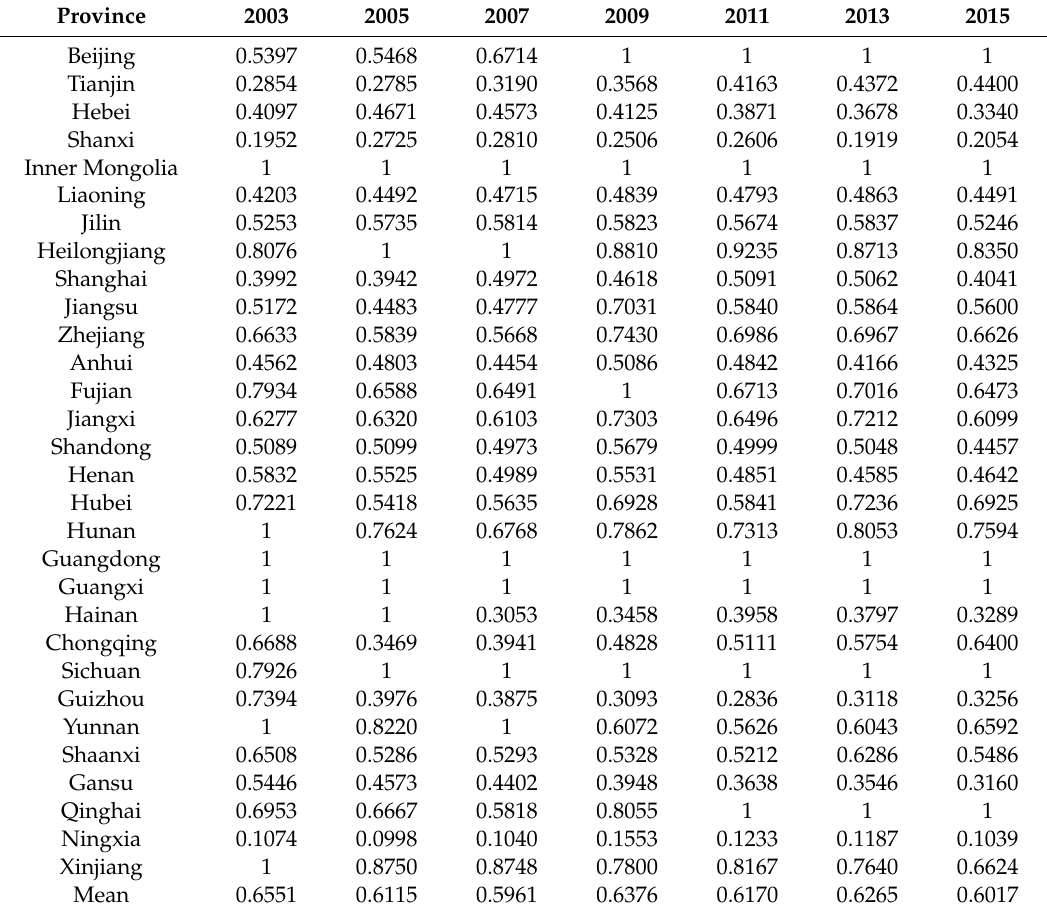
Table 2. Land use eco-e ffi ciency values in China from 2003 to